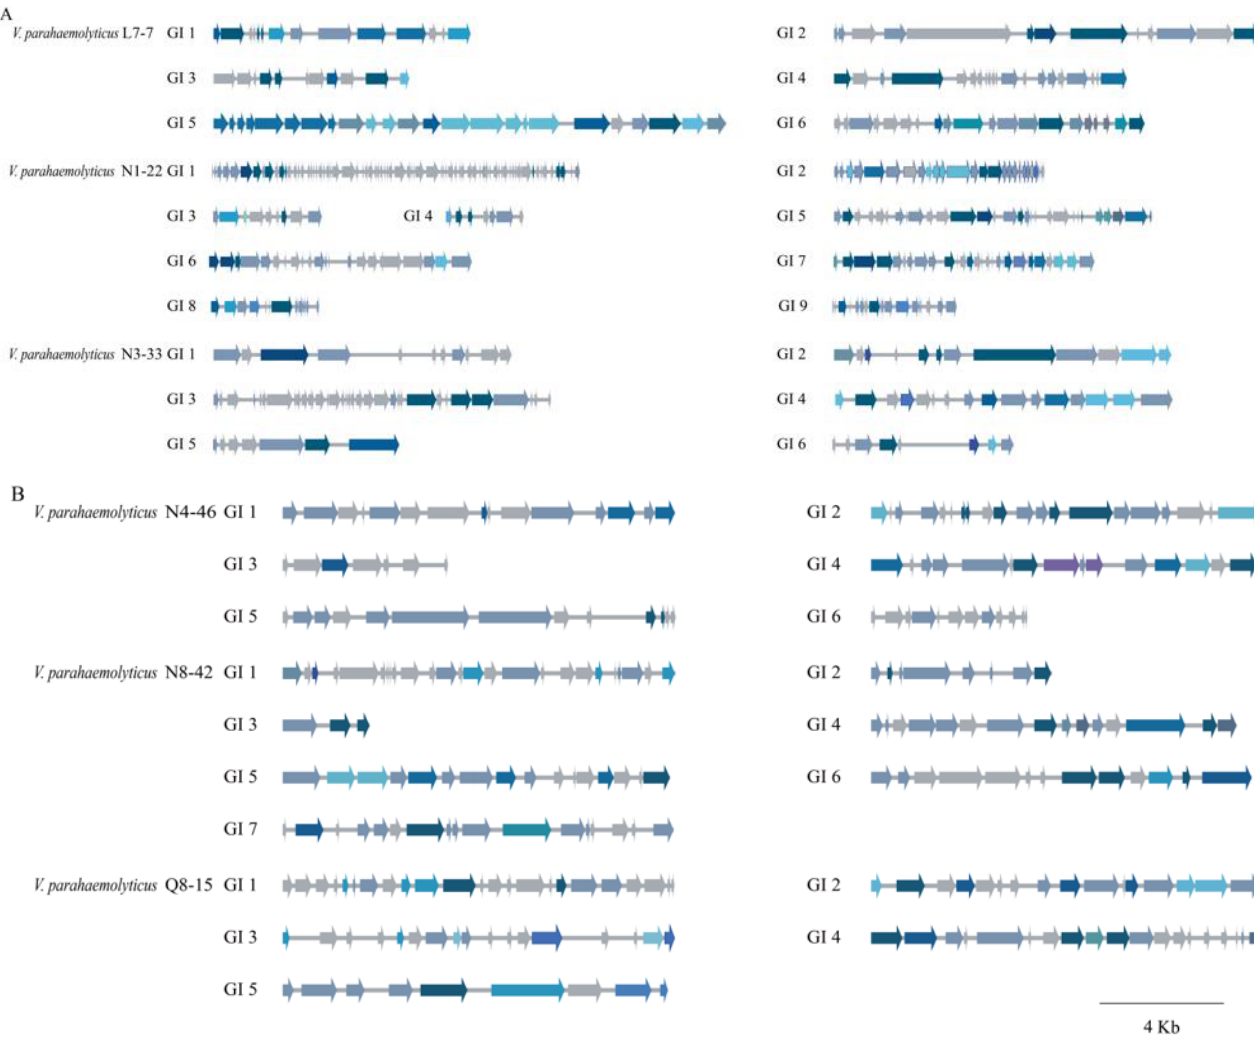
Figure 5. Gene organizations of the GIs identified in the six V. parahaemolyticus genomes ( A , B ). Different colors referred to COG classification to mark gene functions and genes not annotated to COG database were displayed in grey.